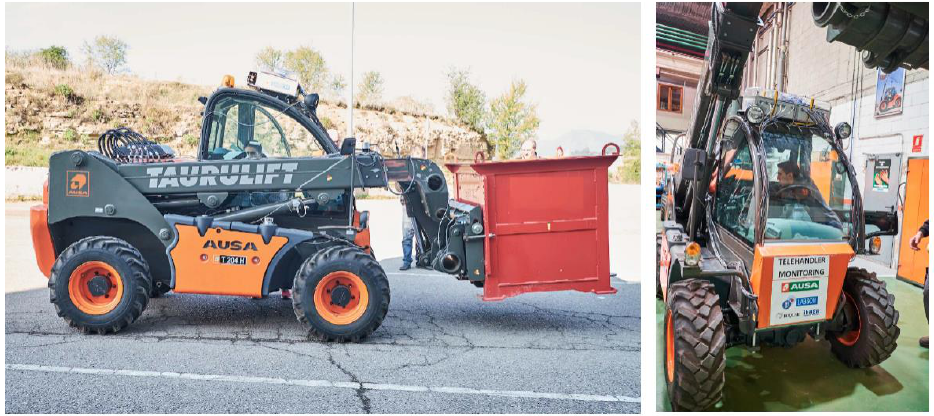
Figure 11. The telehandler machine conveniently instrumented. The hydraulic cylinder was actuated by means of a manual directional control